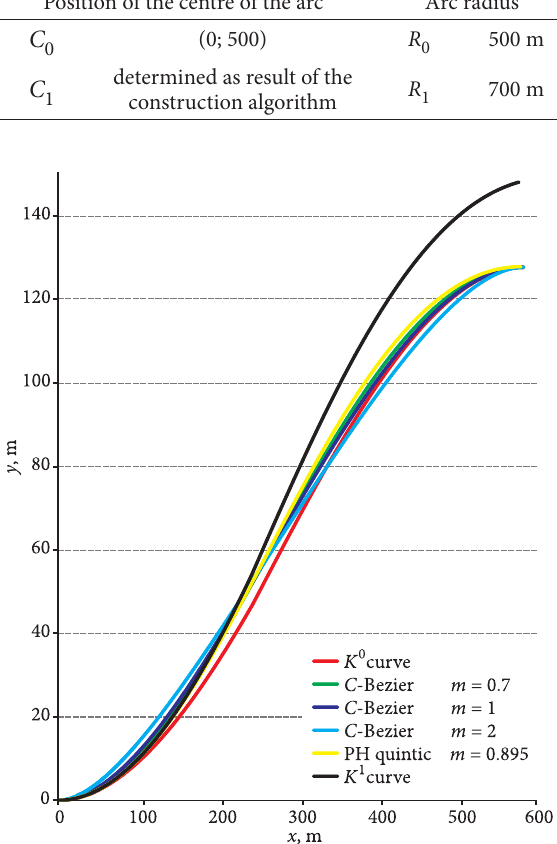
Fig. 8. Schema of S -shaped joining of the circular arcs using PH quintic Bezier curve